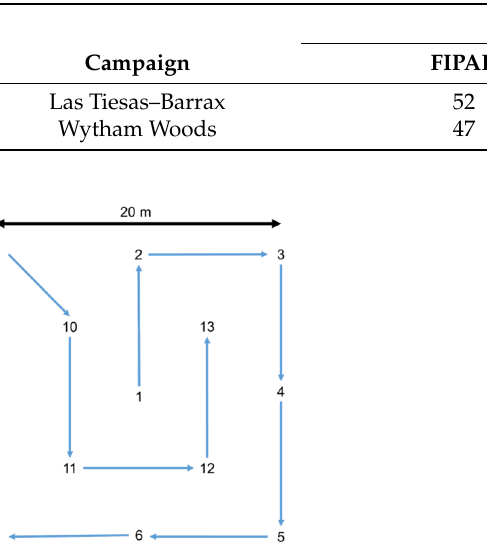
Table 1. Number of ESUs characterised for each variable and campaign.